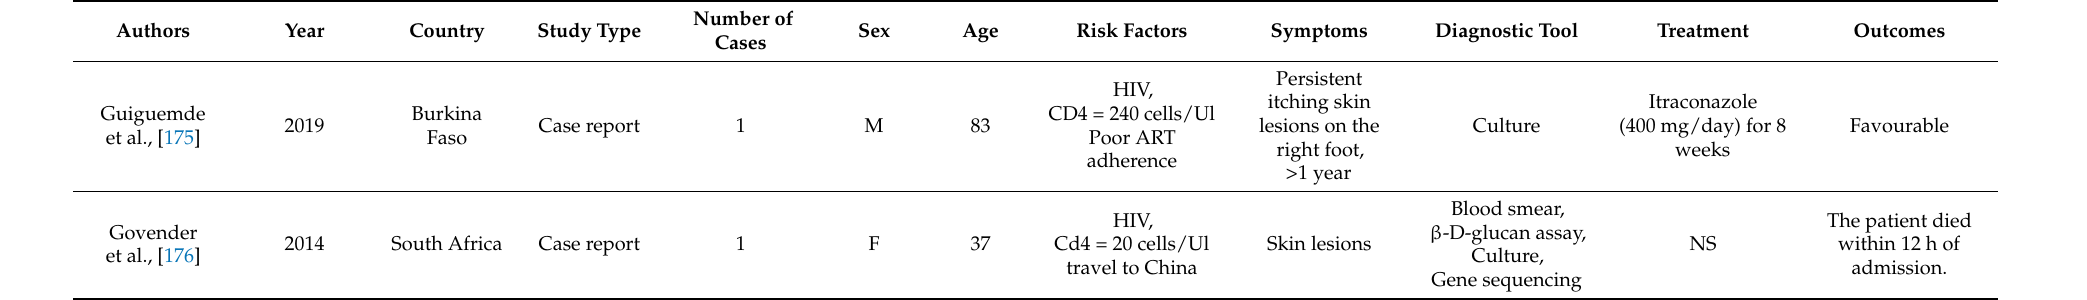
Table 7. Published cases of Talaromycosis in Africa.